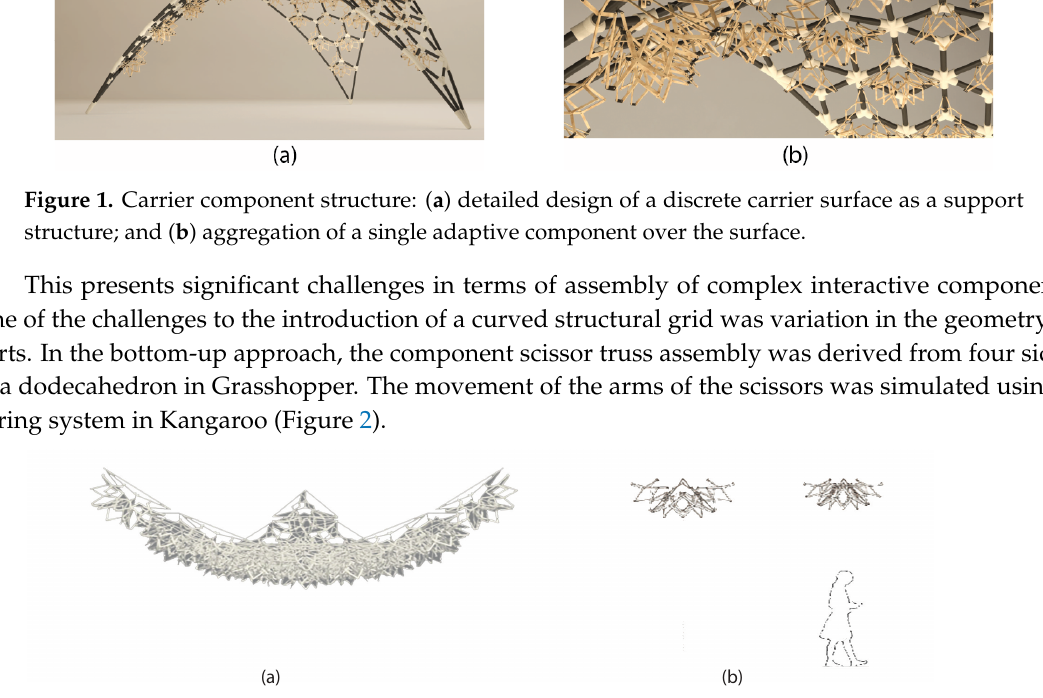
Figure 2. ( a ) Design rendition of responsive envelope on carrier surface; and ( b ) adaptive component triggering closed and open states through motion.